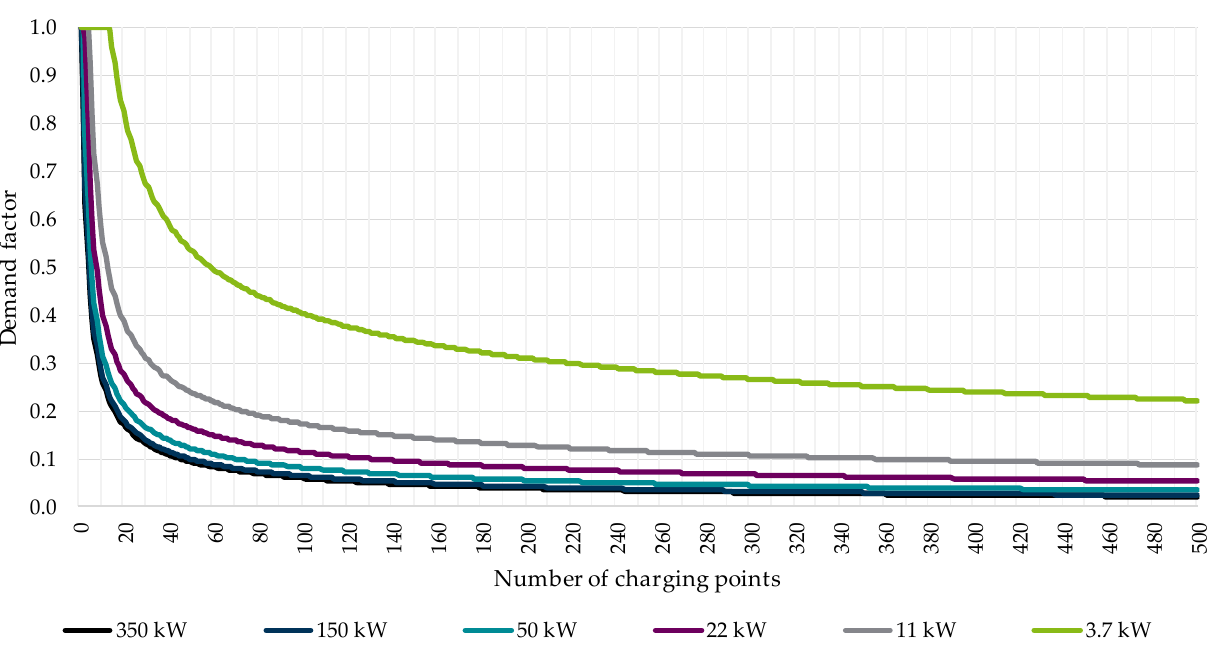
Figure 12. Demand factors (ordinate) for the area type “Urban Region: Regiopolis, Large City” and six charging powers.